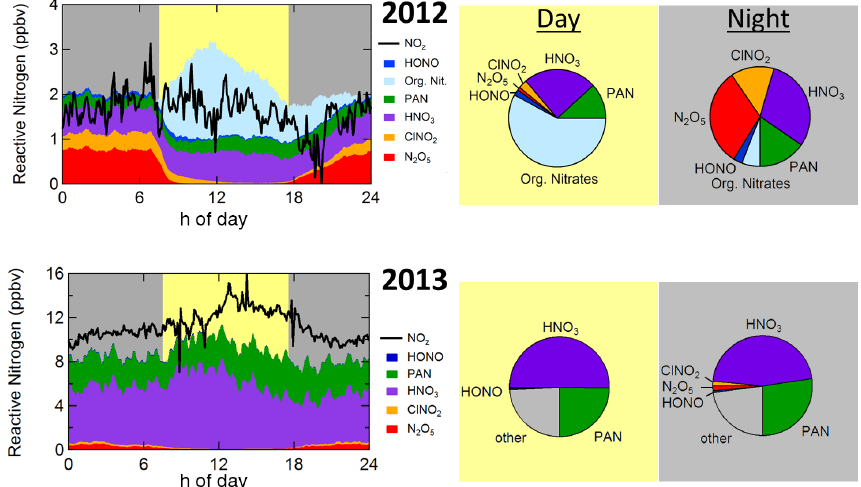
Figure 4. Partitioning among reactive nitrogen species for 2012 and 2013, shown as diel averages (left) as well as daytime and nighttime pie charts (right). We take total NO z to be the sum of components in 2012, and the difference between NO y and NO x in 2013. The missing NO z in 2013 (labeled “other” in the pie charts) is likely organic nitrates, for which we do not have measurements in 2013. In 2012, daytime organic nitrates and nighttime N 2 O 5 and ClNO 2 play an important role compared to 2013, where total PANs and HNO 3 are the largest contributors to NO z .